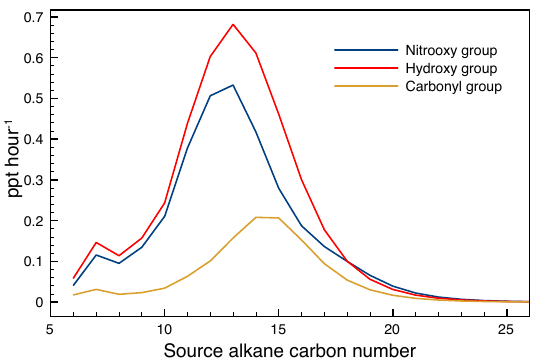
Figure 5. Source strength of functional groups for molecules con- tributing to aerosol formation on 30 January categorized by carbon